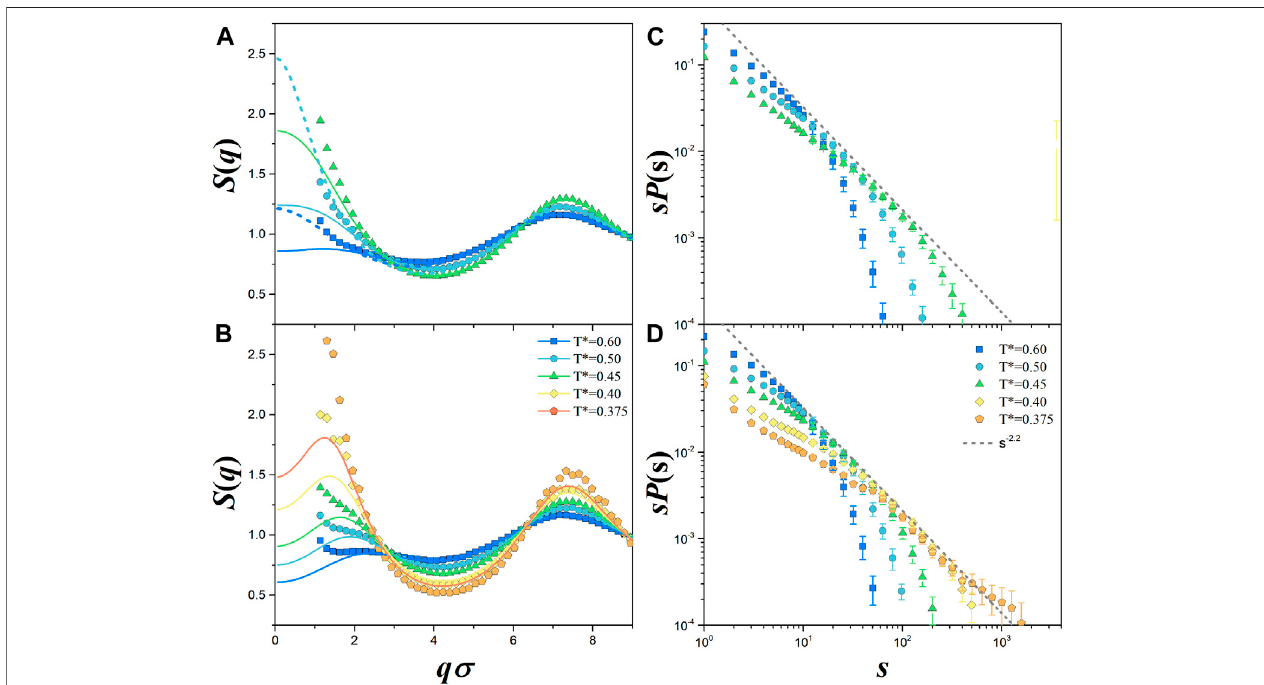
FIGURE1| Structure factorforcompetinginteractionsystemswhoserepulsion strengthis (A) A (cid:2) 0 . 2and (B) A (cid:2) 0 . 5at ϕ (cid:2) 0 . 1anddifferenttemperatures. (C,D) display the cluster size distributions for (A,B) , respectively. Computer simulation results are denoted by symbols, while solid lines are the theoretical solution of the Ornstein-Zernike equations with the Percus-Yevick closure. In (A) we also include the S ( q ) for the reference system the SW potential, i.e. , A (cid:2) 0 (dashed lines). In (C,D) we also include P ( s ) ∼ s − 2 . 2 (solid line), the limit case for random percolation, see [35].